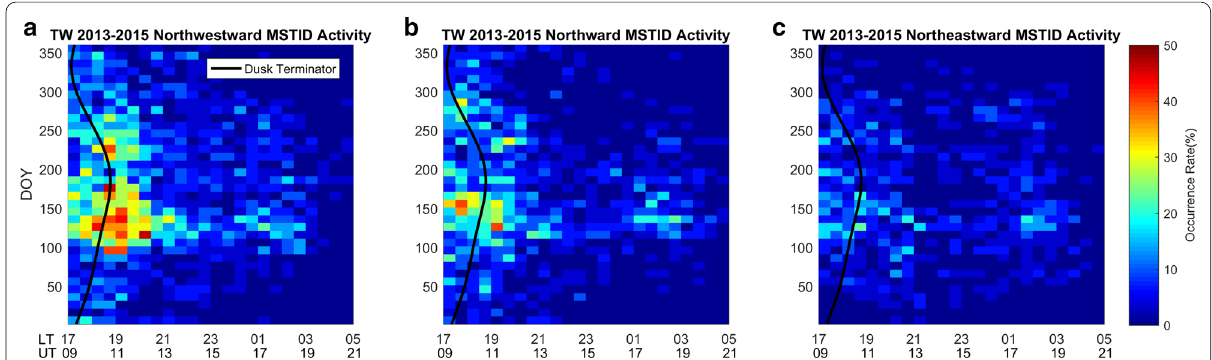
Fig. 4 The occurrence rate of a northwestward, b northward and c northeastward MSTIDs over Taiwan in nighttime during 2013–2015. The black lines indicate the dusk